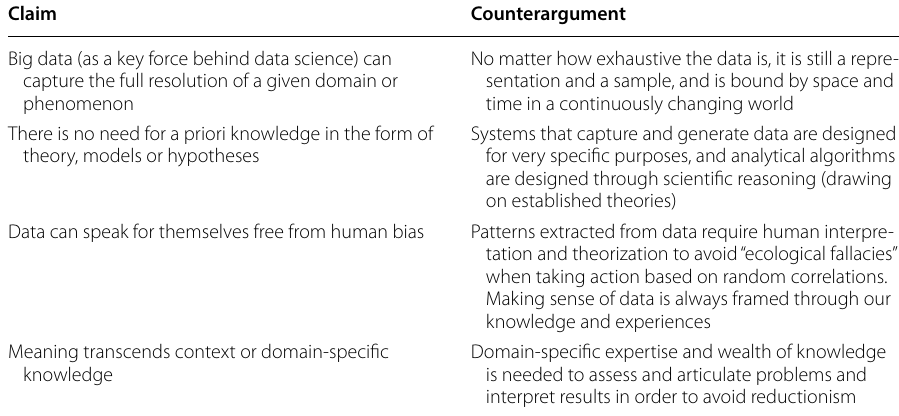
Table 3 Fallacies of empiricism according to [9] Claim